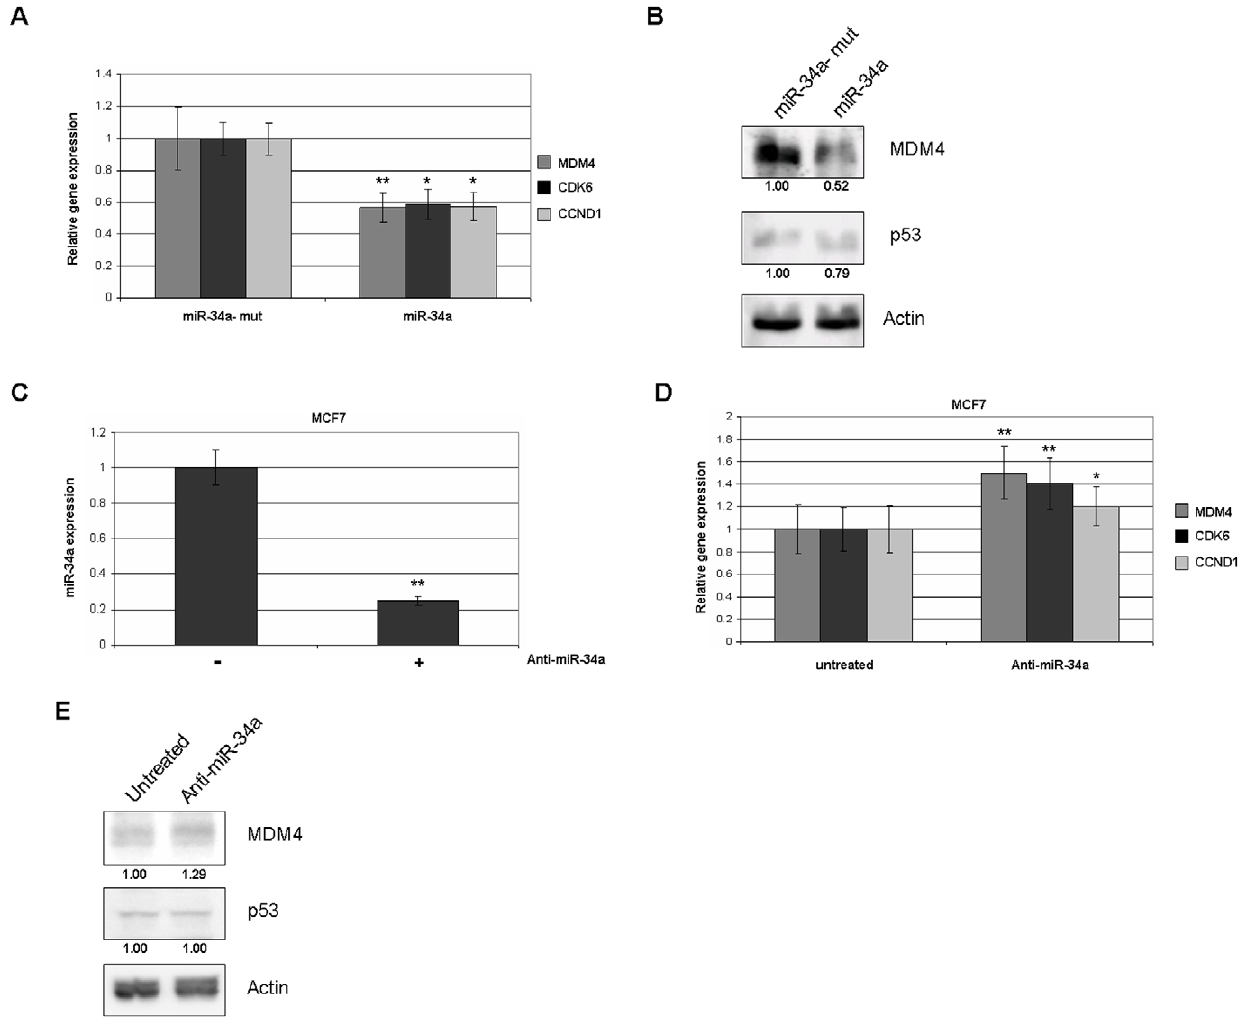
Figure 2. Endogenous MDM4 is repressed by miR-34a. (A) MCF7 cells were transfected with expression plasmids for miR-34a or a control mutant of miR-34a. Total RNA was extracted after 48 hours, and RT-qPCR was used to quantify the expression of MDM4 and the known miR-34a target genes CDK6 and CCND1. Expression is relative to the control (miR-34a-mut) transfection condition. Data are the averages of at least three independent experiments. Error bars show 95% confidence intervals. Asterisks and double asterisks indicate t-test values , 0.05 and , 0.01, respectively, comparing the miR-34a expression plasmid to the control mutant. (B) MCF7 cells were transfected as in (A), and whole cell lysates used for immunoblots to detect MDM4, p53, and beta-actin. Quantification relative to the 34a-mutant condition and normalized to actin are shown below each panel. (C and D) MCF7 cells were transfected with an inhibitor of miR-34a (anti-miR-34a) for 48 hours. RT-qPCR was performed for miR-34a, MDM4, and known miR-34a target genes. (E) Following transfection with miR-34a inhibitor as before, total protein was extracted and immunoblots were performed for the indicated proteins in MCF7.